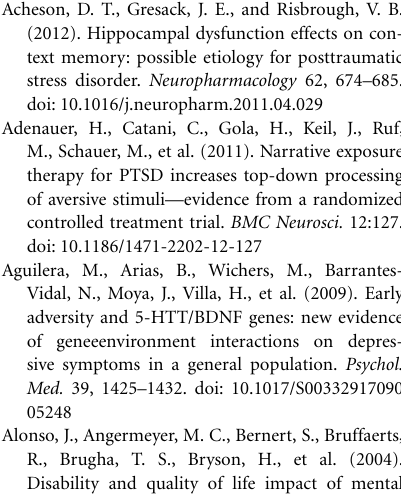
of val/met genotypes was two-fold higher in individuals with probable-PTSD than in controls. The frequency of the BDNF val66met genotypes was significantly higher in those with PTSD and in those with exaggerated startle (a core symp- tom of PTSD) than in non-PTSD